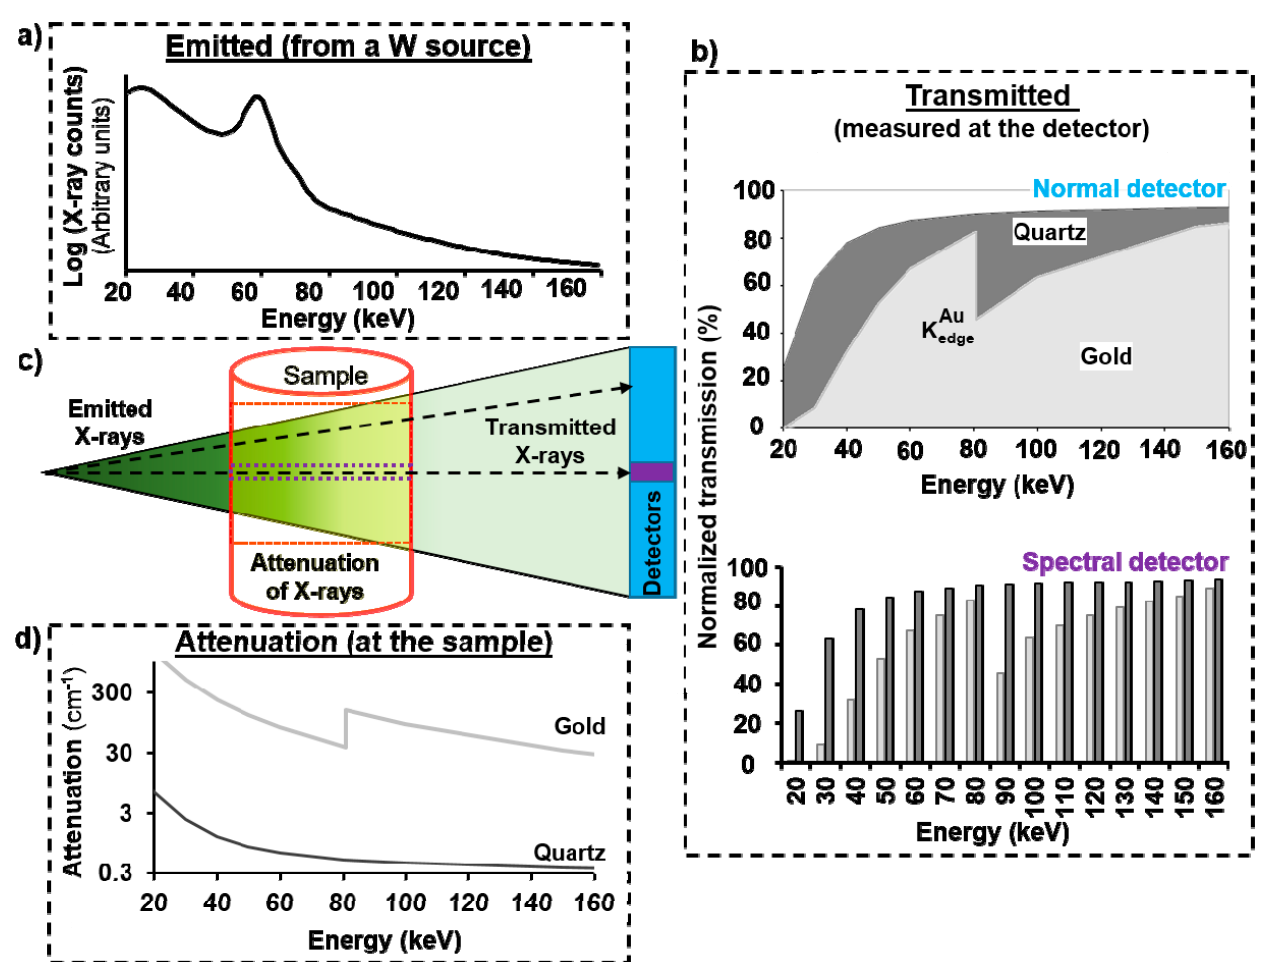
Figure 1. Example of the polychromatic nature of the X-ray spectrum emitted by the tungsten source of the CoreTOM scanner ( a ), and the spectrum transmitted through a sample of quartz (dark grey) or gold (light grey) ( b ). As schematized in ( c ), changes between emitted and transmitted X-rays take place in the sample. The simulated relation between X-ray attenuation and energy taking place across a gold or quartz sample is shown in ( d ). Note that the spectral detector measures the X-rays within discretized bins of energy while a normal detector only measures the total amount of X-rays at all energies (area under the curves).